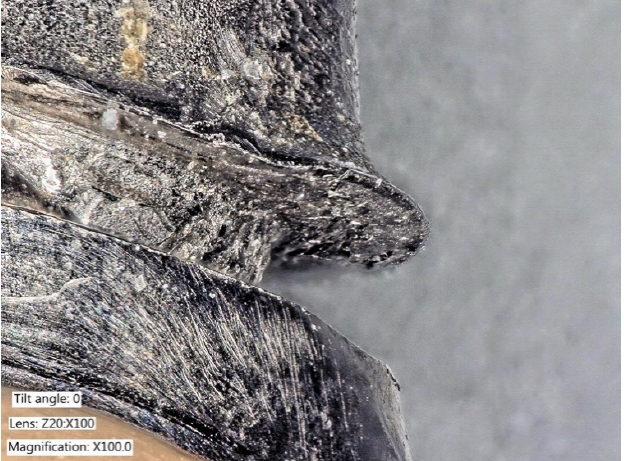
Figure 12. Corrosion of the abutment can occur and appears as pits, or color changes (dark, brown or yellow) distinguishable from the natural gray color of the implant.